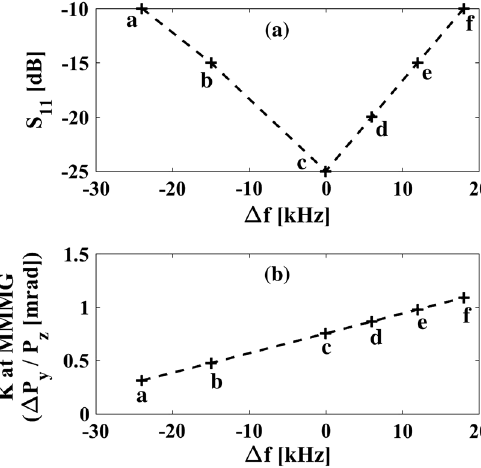
FIG. 8. Simulated reflection coefficient and kick dependency on frequency